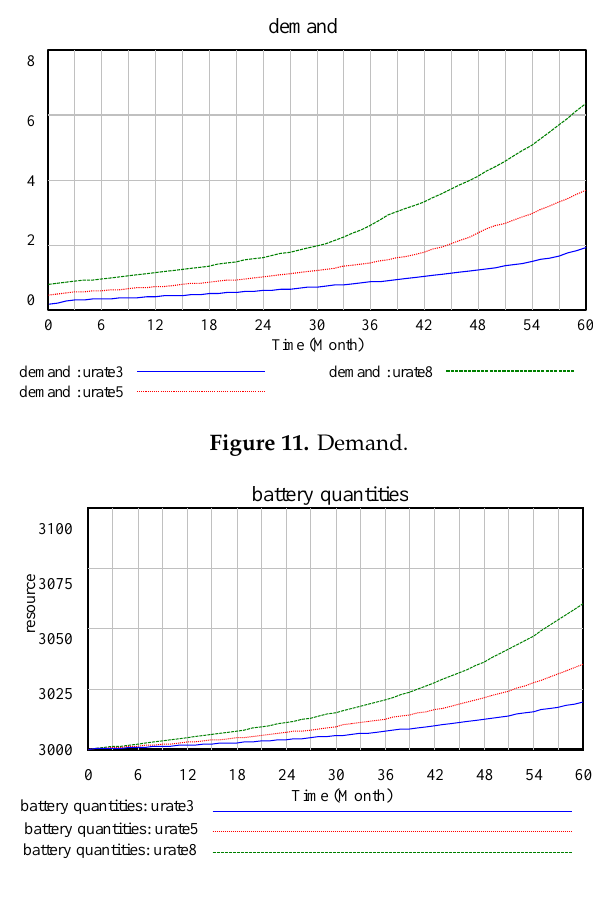
Figure 12. Battery Figure 12. Battery quantity. Figure 12. Battery quantity.